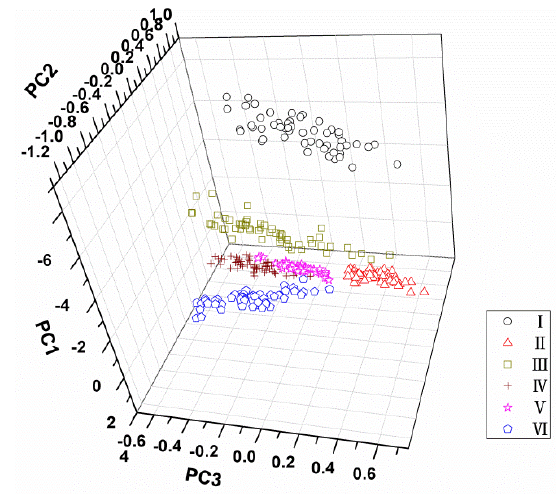
Figure 4. Score cluster plot with PC1× PC2 × PC3 of each maize